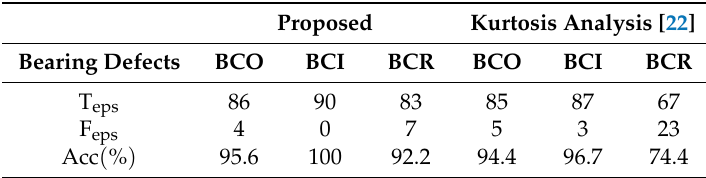
Table 3. The accuracy of bearing defect detection with 300 Table 2. The accuracy of bearing defect detection with 300 r/min.